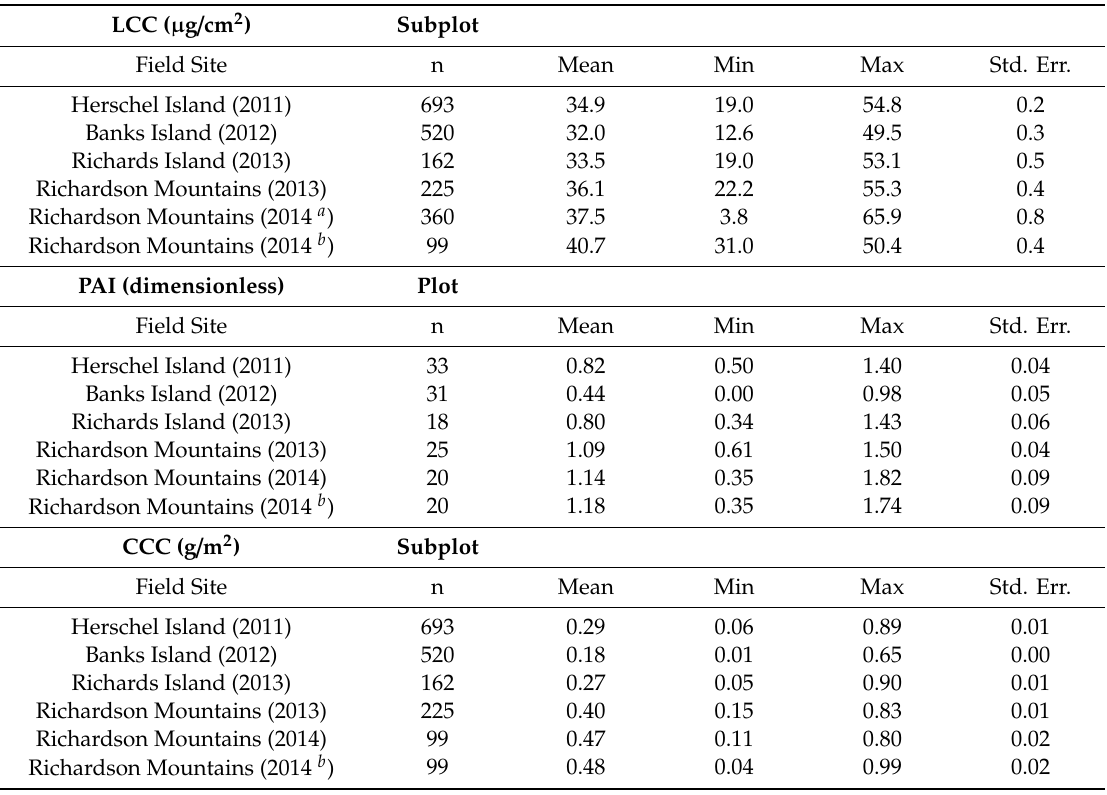
Table 1. Descriptive statistics for: (1) converted and destructive LCC values ( µ g / cm 2 ), (2) measured and destructivePAIvalues(dimensionless), and(3)measuredanddestructiveCCCvalues(g / cm 2 )forallfield sites. Plots with zero values excluded (no leaf measurements taken). Lab-based (spectrophotometric) LCC values are indicated with a superscript a . Destructive field-based values are denoted with a superscript b . Standard error (Std. Err.) was calculated by dividing the standard deviation by the square root of the sample size. LCC and CCC are displayed for the subplot scale (1 m 2 ), whereas PAI values are shown for the plot scale (90 × 90